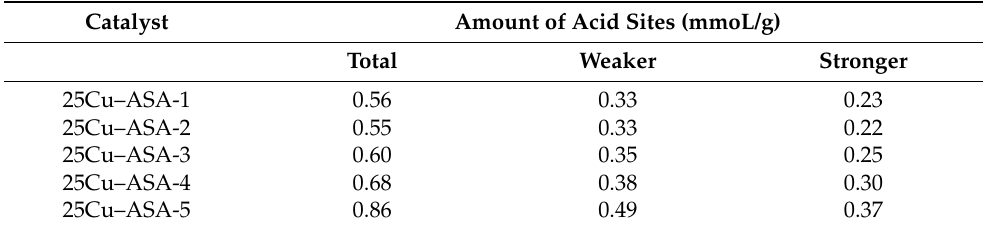
Table 2. The calculated amounts of acid sites of the 25Cu–ASA- y catalysts.